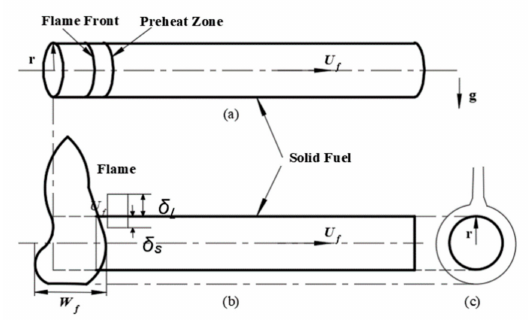
Figure 2. Schematic diagram of cable flame ( a ) flame front, ( b ) front view of the flame, ( c ) side view of the flame.